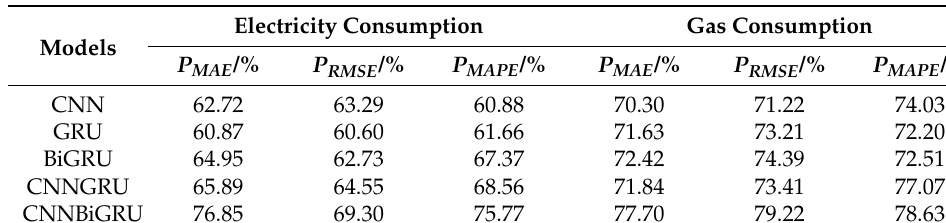
Table 6. Optimization percentage of integrated SSA method for prediction error evaluation indicators under one-step ahead prediction.